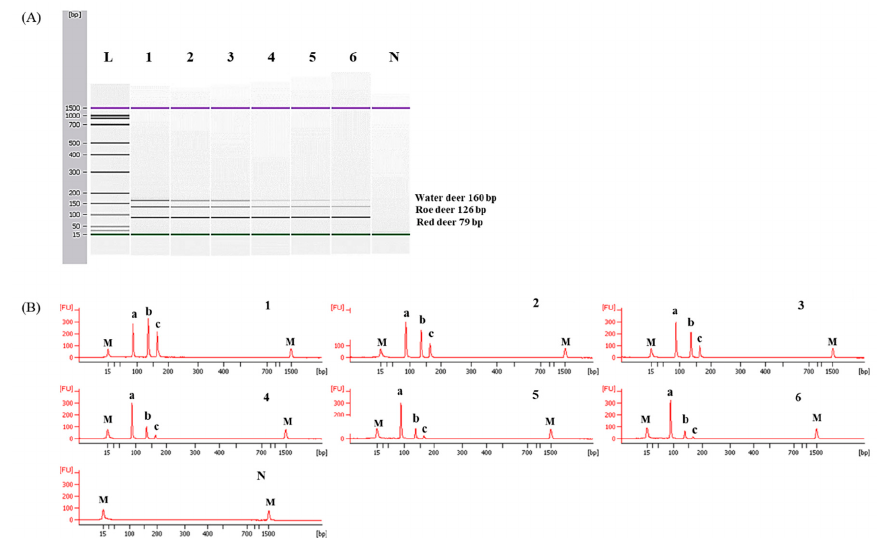
Figure 6. Detection limits of roe deer and water deer in red deer by the multiplex PCR assay. Gel image ( A ) and electropherograms ( B ). FU: fluorescence, M: alignment marker, lane L: 100 bp DNA ladder, lane 1: positive control (10 ng of each DNA from target species), lanes 2–6: 10, 5, 1, 0.5, and 0.1% roe deer and water deer in red deer, and lane N: non-template. a, b, and c indicate red deer, roe deer, and water deer, respectively.